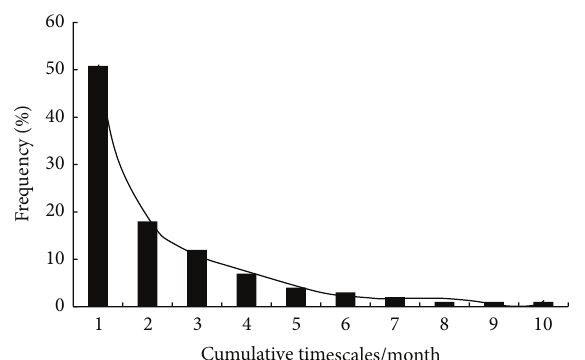
Figure 3: Frequency distribution of cumulative